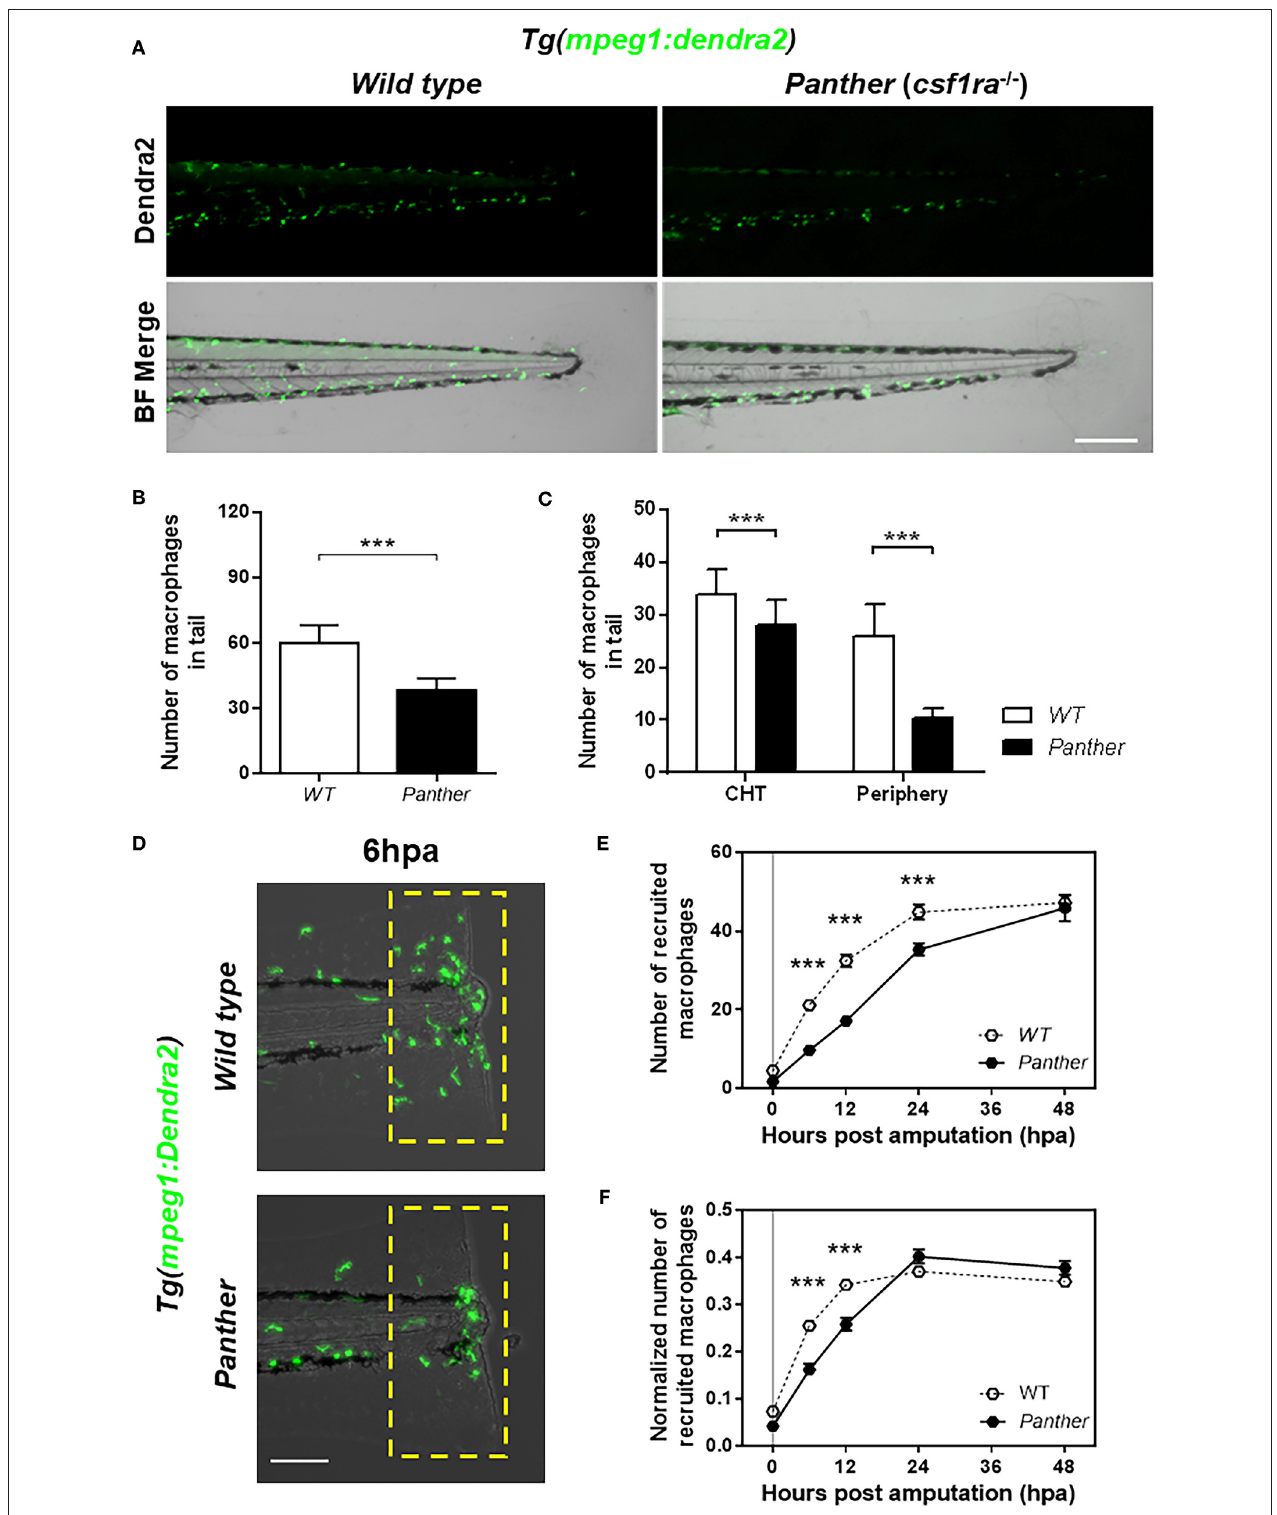
FIGURE 2 | Panther ( csf1ra − / − ) larvae have a fewer peripheral macrophage population and a delayed recruitment of macrophages after tail fin amputation. (A) Representative images of Tg(mpeg1:Dendra2) larvae in a wild type (WT) or a panther genetic background. Scale bar = 250 µ m. (B) Total number of